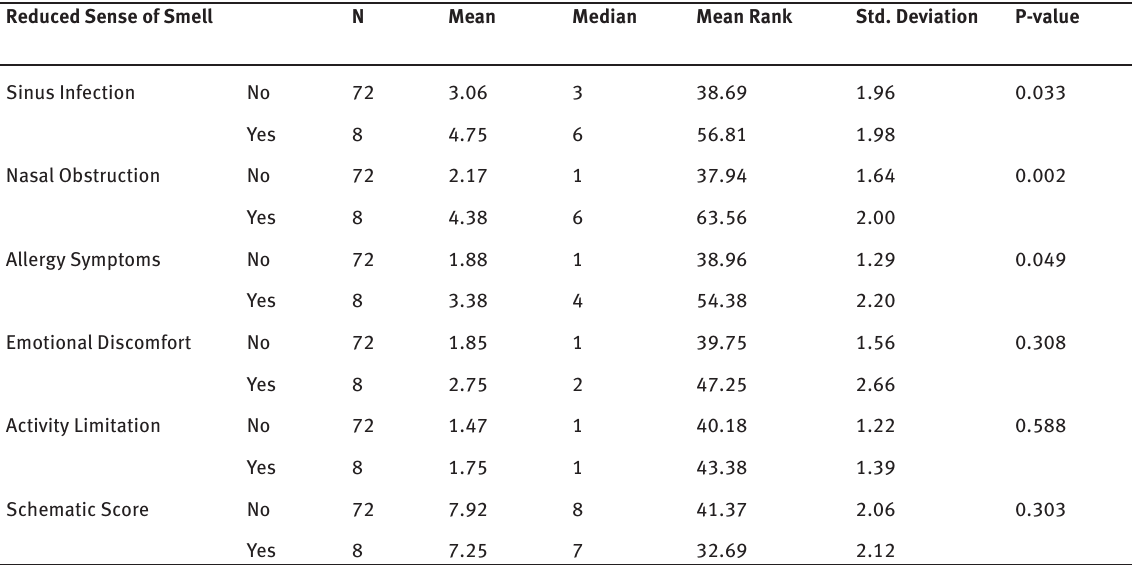
Table 3: Comparison of quality of life scores between people with reduced sense of smell and those no reduced sense of smell using the Nonparametric Mann-Whitney U test.